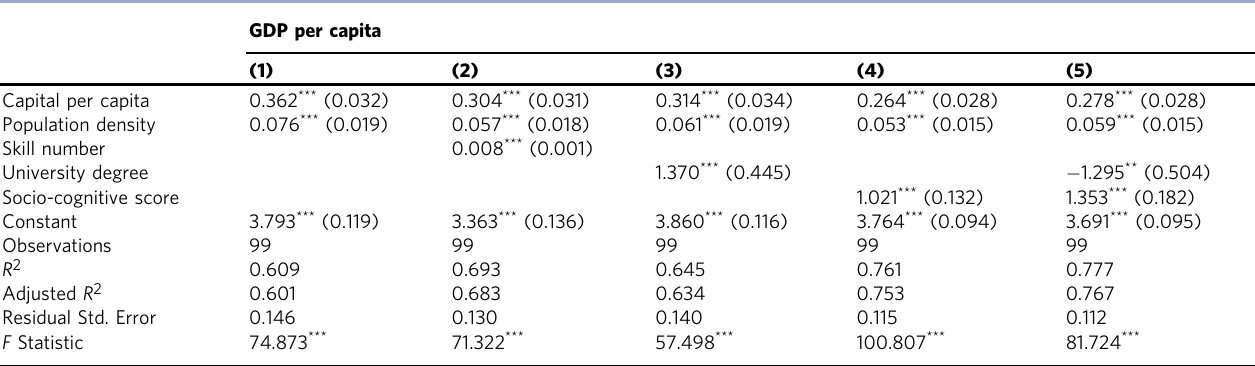
Table 1 Estimating effects of education and skill pro fi le on urban